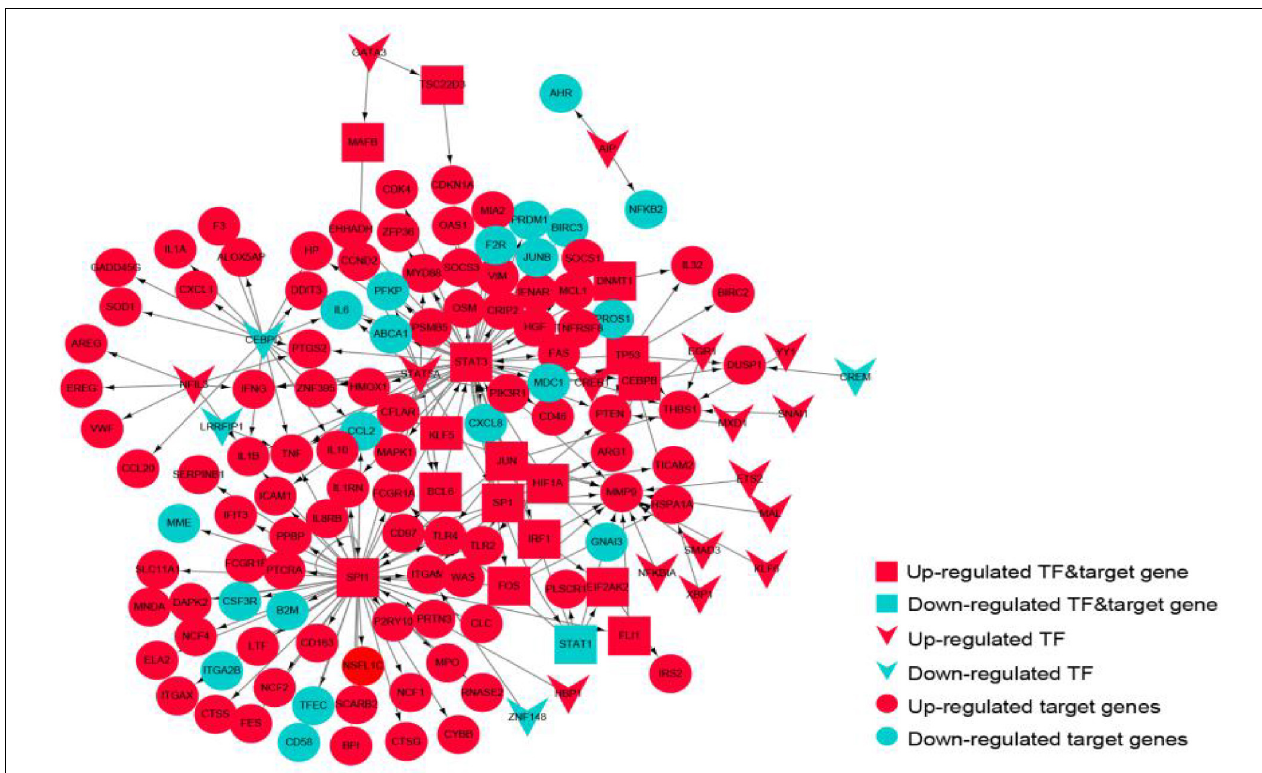
FIGURE 10 | The transcriptional regulatory network of the crosstalk genes. Red represents up-regulated genes, blue represents down-regulated genes, circles represent target genes, arrows represent transcription factors, and rectangles represent targets. TABLE 3 | Top 10 ranked genes in the transcription factor-crosstalk gene regulatory network. SYMBOL Outdegree Average Shortest Path Length Betweenness Centrality Closeness Centrality Clustering Coefficient